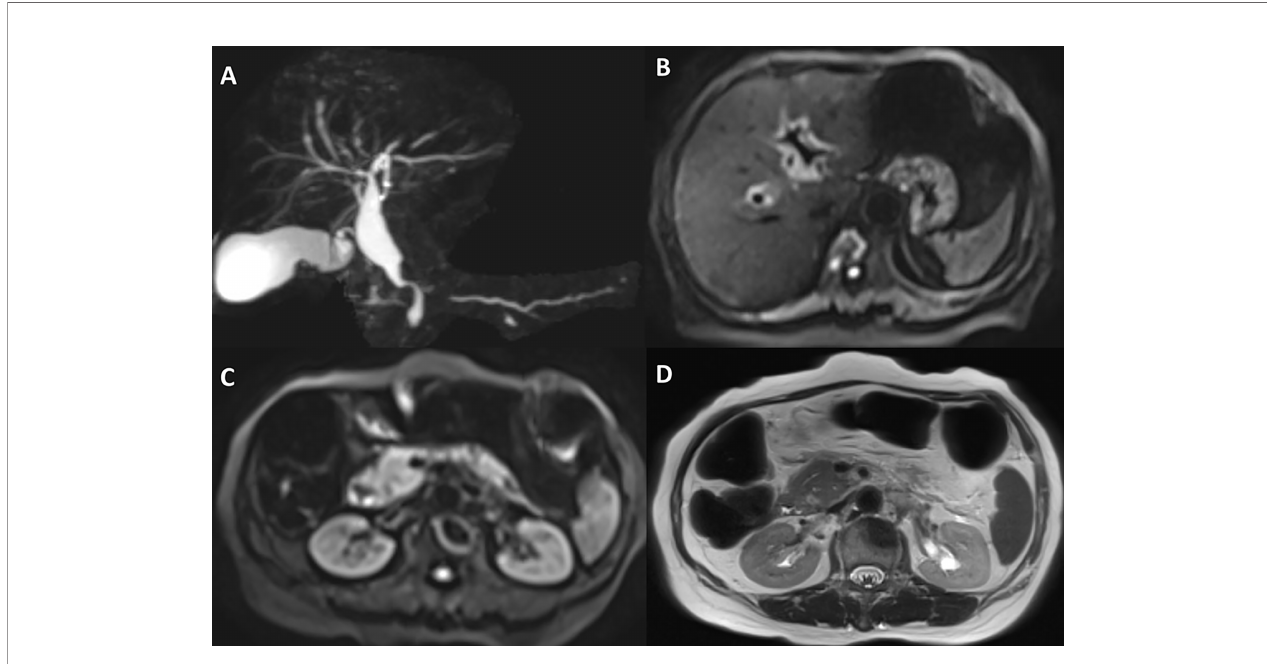
FIGURE 2 | Magnetic resonance cholangiopancreatography and abdominal magnetic resonance imaging. (A) Magnetic resonance cholangiopancreatography shows highly suspected diffuse hypertrophy of the extrahepatic biliary tract, inferior biliary tract stenosis, and multiple strictures of the intrahepatic biliary tract. (B) Abdominal magnetic resonance imaging suggests that the intrahepatic bile duct wall is signi fi cantly thickened, and diffusion was signi fi cantly restricted on diffusion-weighted imaging. (C) Diffusion-weighted imaging reveals that the entire pancreas demonstrated diffuse high signal. (D) A thickened peritoneum is